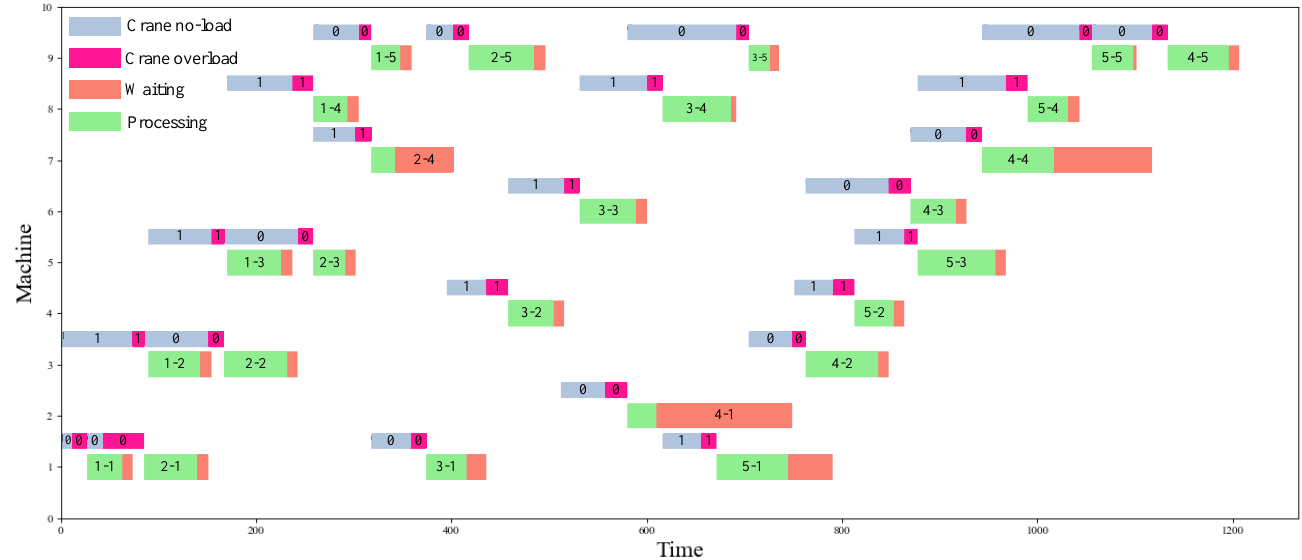
Figure 6. Scheduling Gantt chart (NVF-FRO).